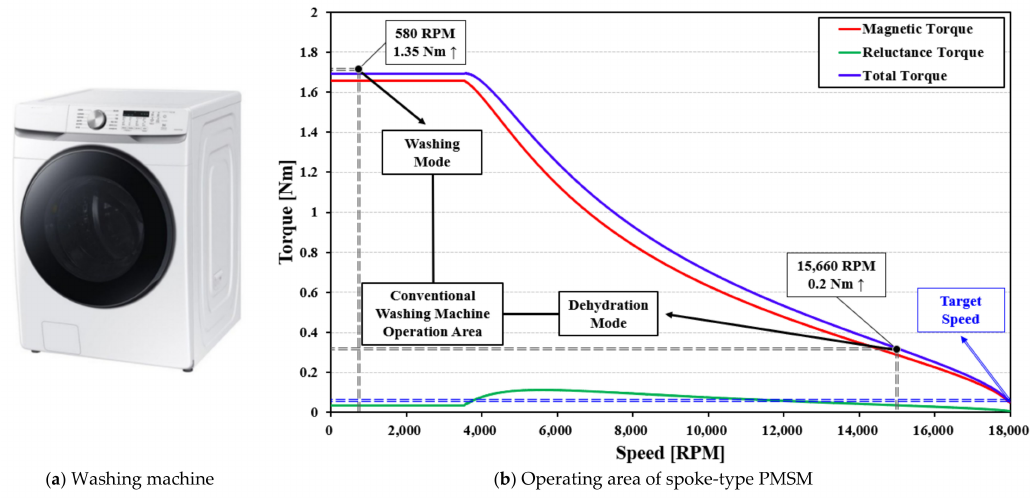
Figure 1. Operation area of spoke type motor used in the conventional washing